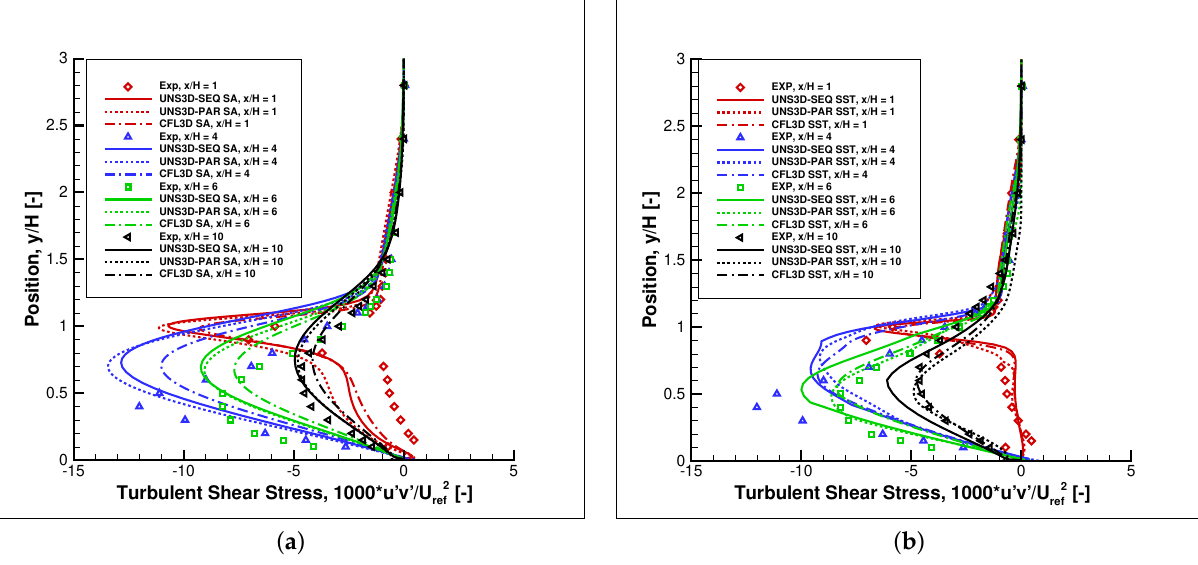
Figure 21. Dimensionless turbulent shear stress on backward-facing step: ( a ) Spalart–Allmaras, and ( b ) Shear Stress Transport.